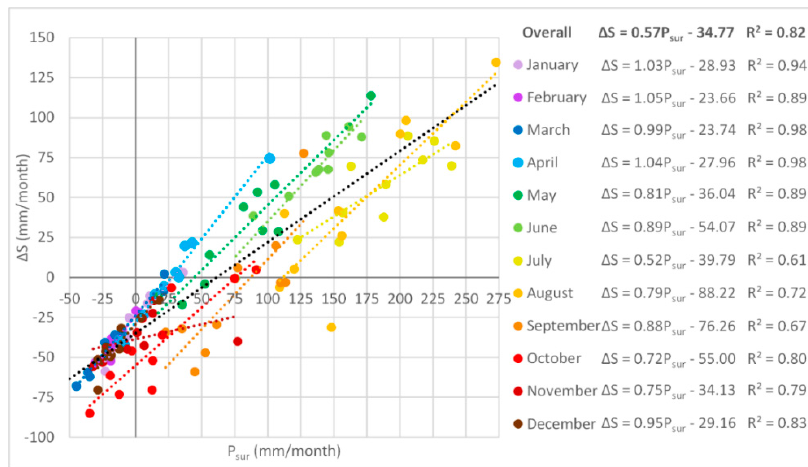
Figure 11. Monthly changes in storage upstream of Son Tay station ( ∆ S) plotted against the rainfall surplus (P sur ). Dashed lines indicate the lines of best fit for each month ( colored ) and the entire year ( black ). For each month, the derived linear model is given on the right with its respective coefficient of determination (R 2 ).